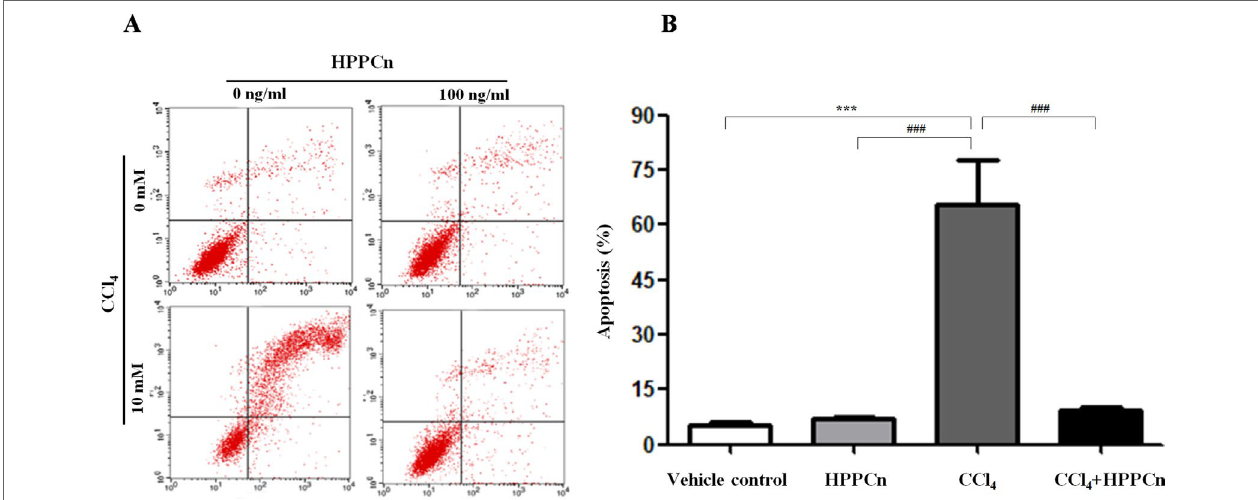
FIGURE 3 | rhHPPCn inhibits the apoptosis of SMMC7721 cells treated by CCl 4 . The cell apoptosis was detected using FITC-conjugated Annexin V and PI by flow cytometry. (A) Image of vehicle control group, HPPCn group (100 ng/ml HPPCn), CCl 4 group (10 mmol/L CCl 4 ), and CCl 4 +HPPCn group (10 mmol/L CCl 4 , 100 ng/ml rhHPPCn). (B) Statistical analysis of the apoptosis rate of the four groups (vehicle control group, HPPCn only group, CCl 4 only group, and CCl 4 +HPPCn group). ** P < 0.01, *** P < 0.001 vs. the vehicle control group; ### P < 0.001 vs. the CCl 4